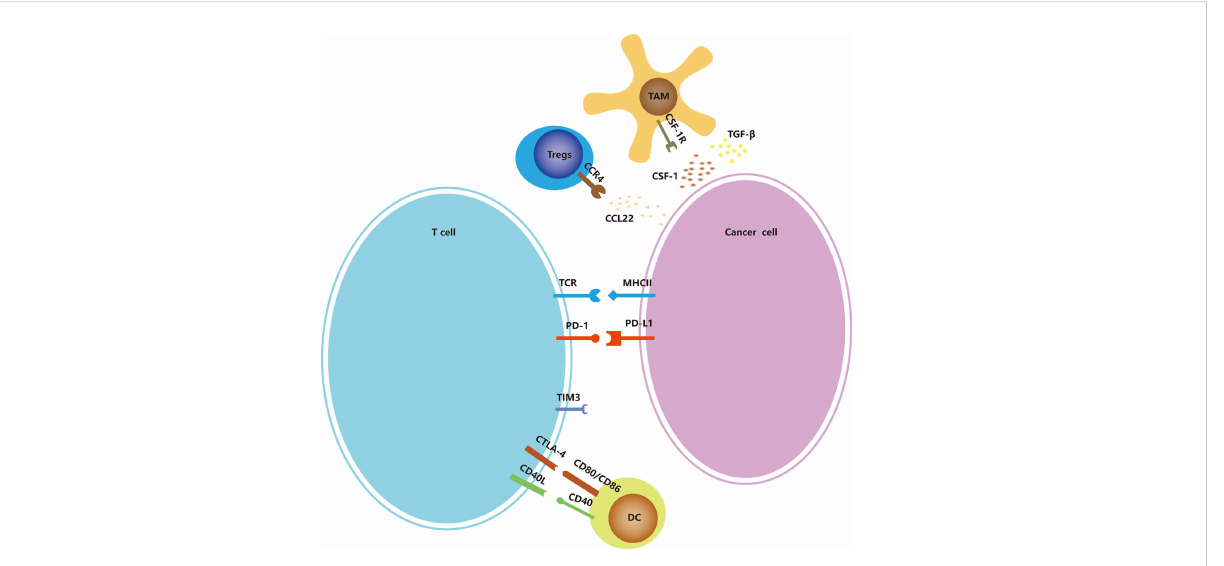
FIGURE 2 Immune-checkpoints and co-stimulatory signaling. Many of the ligands bind to multiple receptors, some of which deliver co-stimulatory signals and others deliver inhibitory signals. The expression of ligands and receptors should not be considered exhaustive; for example, PDL1/PDL2 is also expressed by antigen-presenting cells such as macrophages and dendritic cells (not shown in the fi gure), and MHC-II is also expressed by dendritic cells.